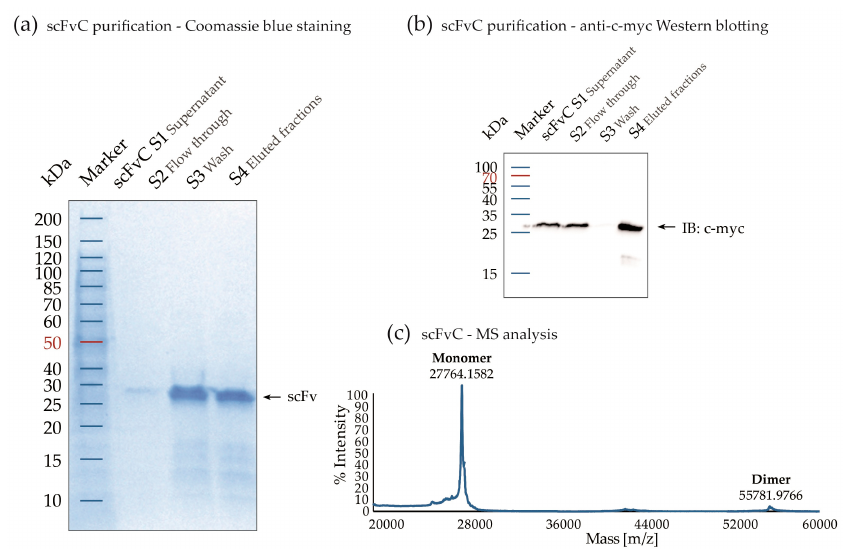
Figure 2. scFv protein expression and purification at an example of scFvC. ( a ) Coomassie brilliant blue staining after SDS-PAGE analysis; ( b ) representative immunoblotting (IB) analysis of scFv purification process. The membrane was stained with anti-c-myc antibodies and proper HRP-conjugated secondary antibodies; and ( c ) the exemplary mass spectrometry spectrum with the highest peak originating from the monomeric fraction of the scFv with the expected molecular mass. Minor peak corresponding to the molecular weight of the covalent dimer was also detected.